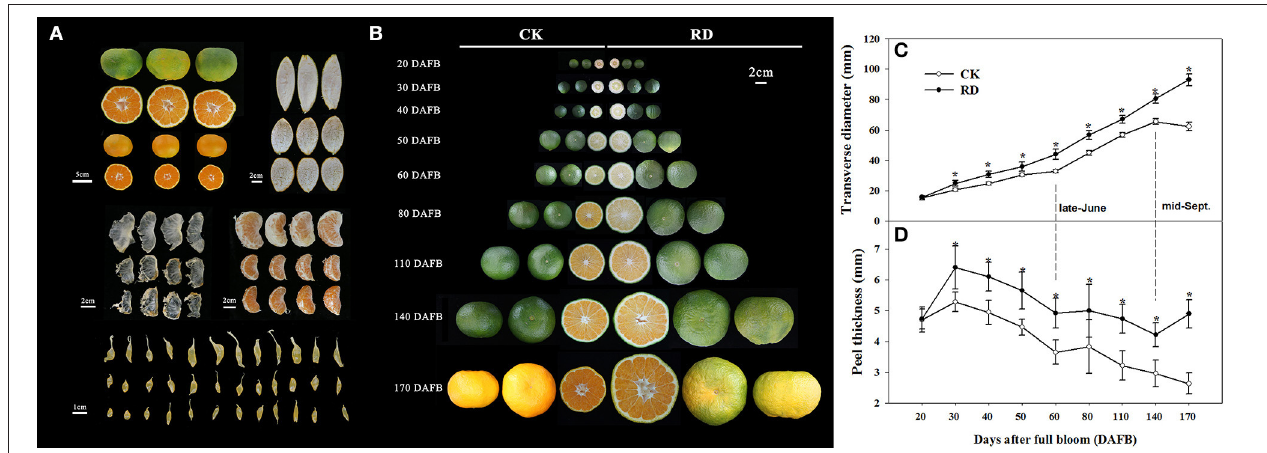
FIGURE 1 | Characteristics and development of Satsuma mandarin fruit with roughing disorder (RD). (A) The exterior and interior characteristics of RD fruit. (B) Fruit development for CK and RD fruits. Fruit size (C) and peel thickness (D) changes throughout fruit development. Asterisk means significant difference at P < 0.05.